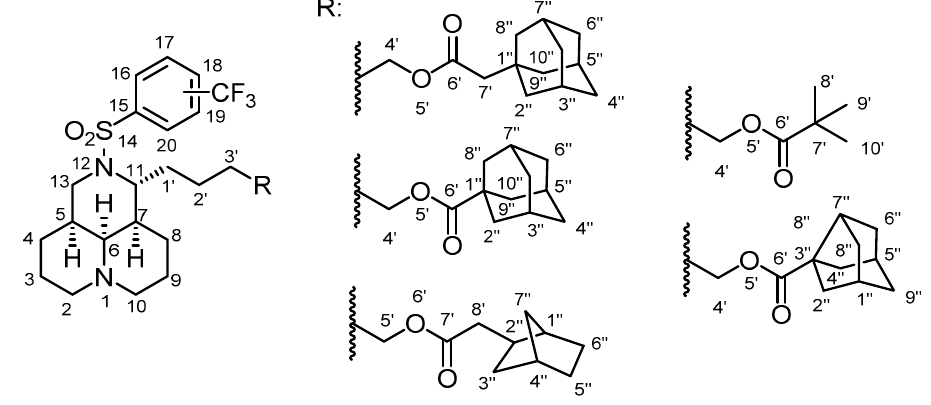
Figure 5. structures and position numbers of the target compounds 9a–j.